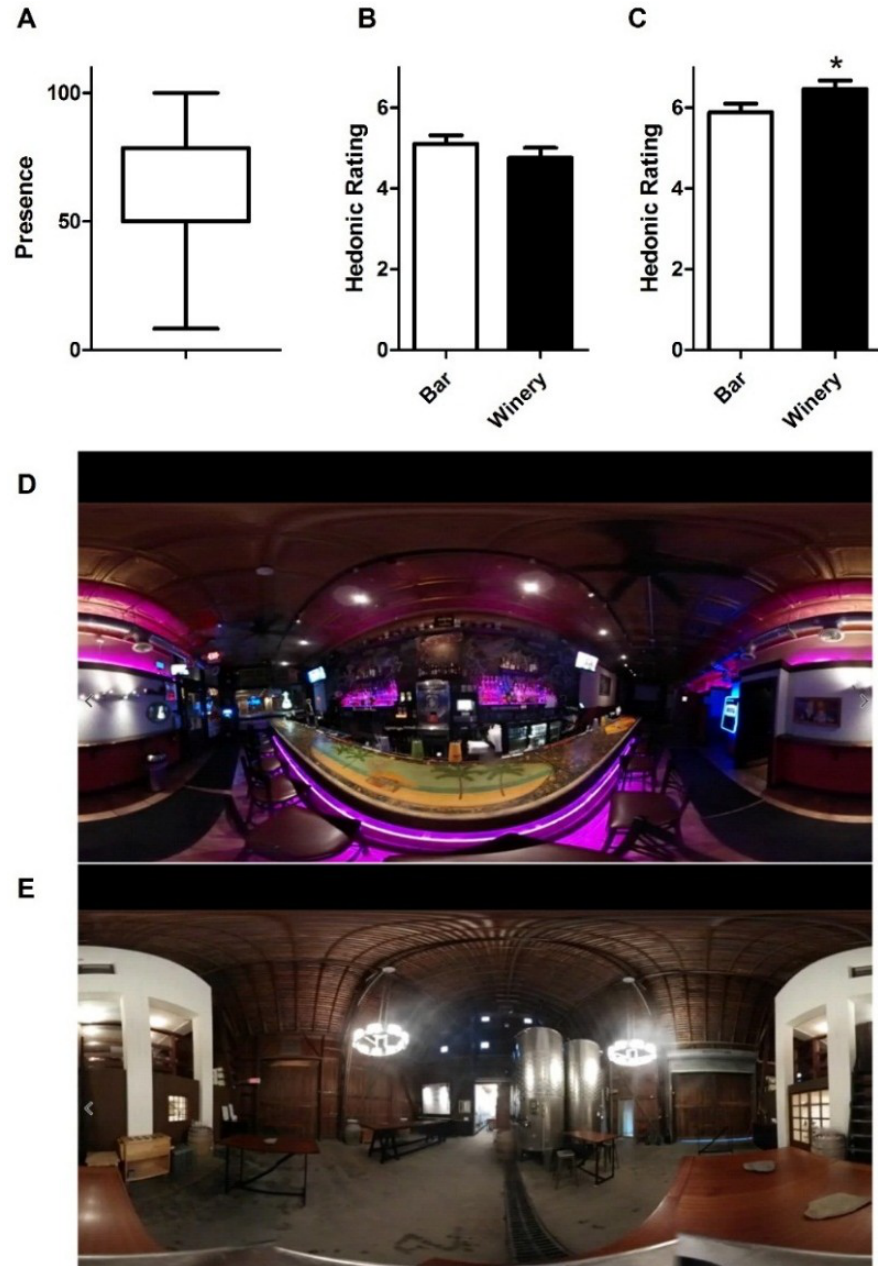
Figure 2. ( A ) Panelists’ feelings of immersion were rated from “not present at all” (0) to “completely present” (100). The box and whisker plot denotes mean of 54 and range (standard dev. = 22). ( B ) Liking for beer was higher, although not significantly, in the bar context (white bar) than the winery (black bar), plus standard error. Samples were rated on a 9-point hedonic scale, with labels indicating “dislike extremely” (1) to “neither like nor dislike” (5) to “like extremely” (9). ( C ) Panelists had higher hedonic ratings for champagne delivered in the winery context as compared to the bar; bars denote mean plus SEM. Asterisk denotes p < 0.05. ( D ) 360 degree virtual bar context. ( E ) 360 degree virtual winery